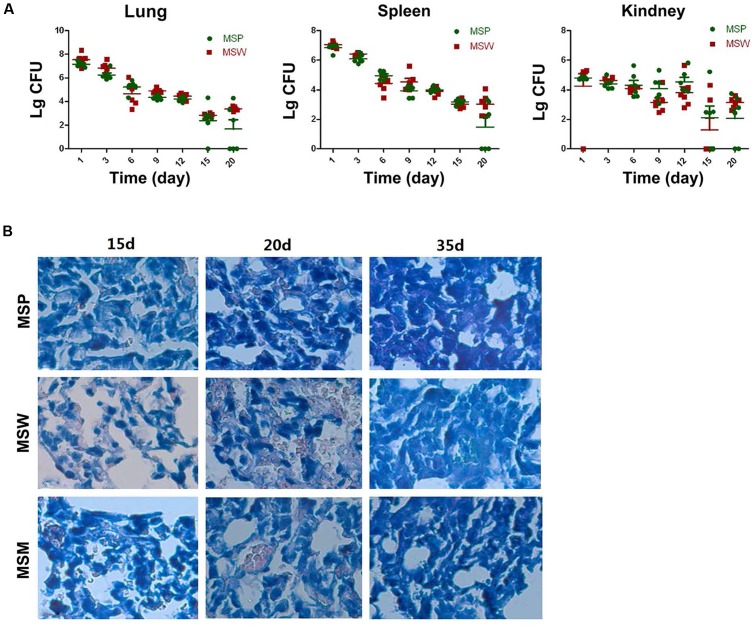
The growth of M. smegmatis strains in different organs of Balb/c mice. (A) Colony forming units (CFU) of M. smegmatis in lung, spleen, and kidney tissues of mice infected with M. smegmatis at different time points (0, 3, 6, 9, 12, 15, and 20 days post-infection). (B) Acid-fast staining of lung tissues of mice infected with different M. smegmatis strains (400×) at different time points (15, 20, and 35 days post-infection). The data are representative of two independent experiments, n = 6.